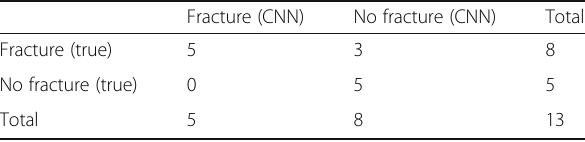
Table 1 Confusion matrix showing the results on the final validation